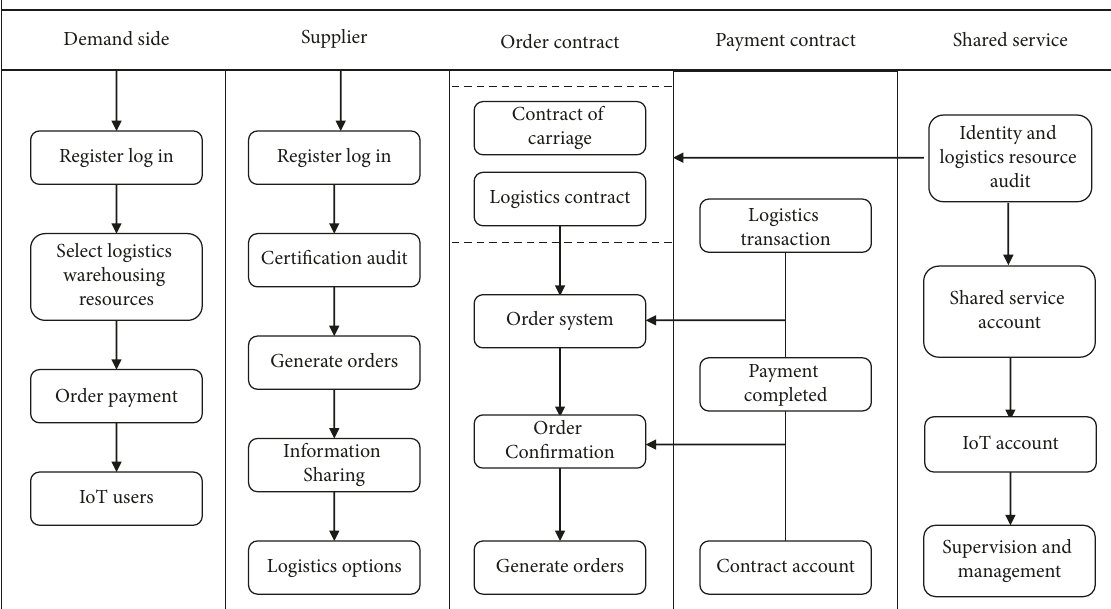
Figure 2: The business logic framework of the logistics distribution information sharing